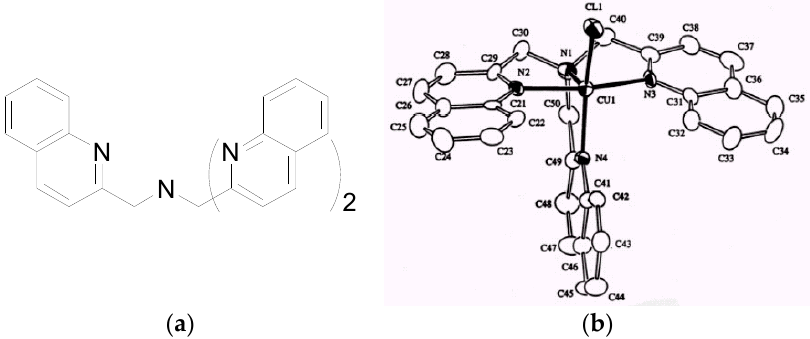
Figure 3. ( a ) Tris(2-quinolylmethyl)amine (TQA) and ( b ) X-ray structure of a TQA-Cu 2+ complex. Reprinted with permission from Reference [32]. Copyright (1994) American Chemical Society.